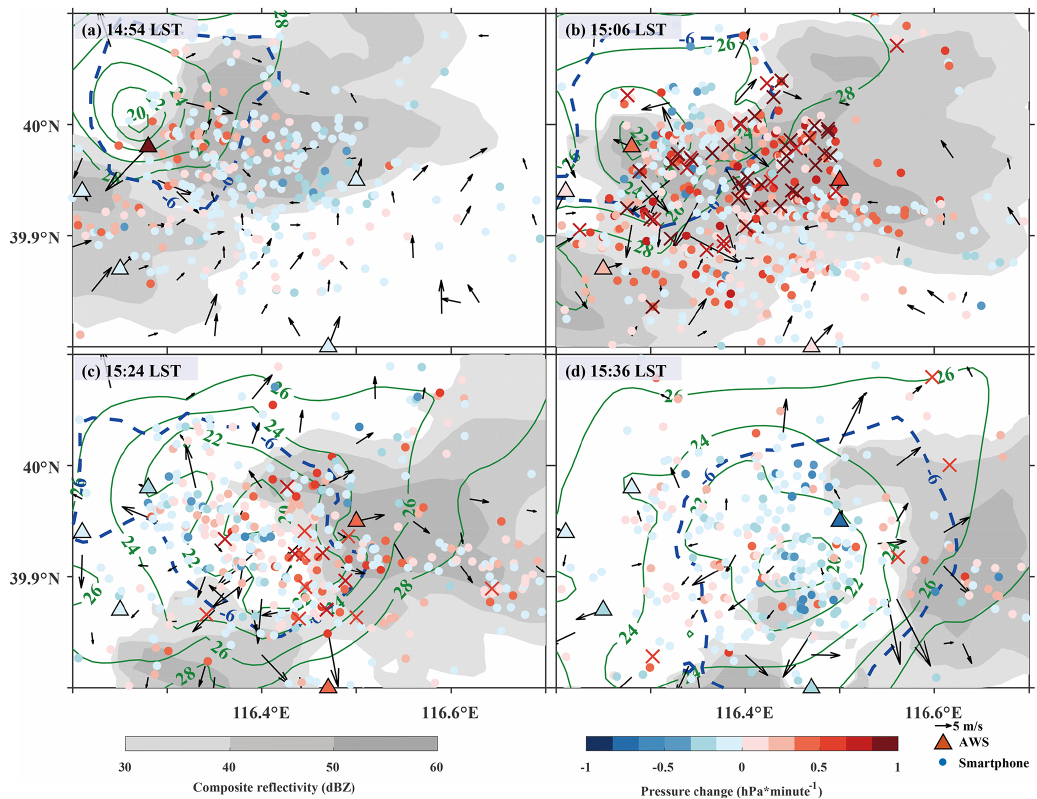
Figure 12. The 5min pressure change from surface stations (triangles) and the 6min pressure change from smartphones (points), temperature observations from surface station (green contour), wind field (black arrow), and composite radar reflectivity (shaded) during a hailstorm that occurred on 10 June 2016 in Beijing, China. The station pressure change is shown at the time closest to that of the radar volume. The “ × ” symbol marks the locations where the 6min pressure change perturbation is greater than 0.52hPa. The dashed blue line is the (cid:49)θ e = − 6K isoline from the analysis of surface observations ( (cid:49)θ e is defined as the difference between the equivalent potential temperature at a point and the domain-averaged value).